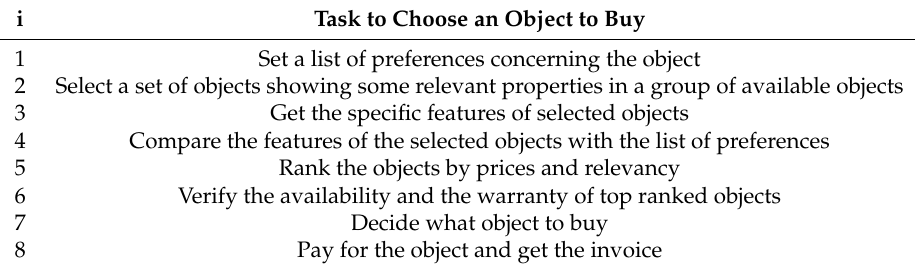
Figure 11. The psychological learning loop [47]. Table 2. Necessary tasks to choose an object to